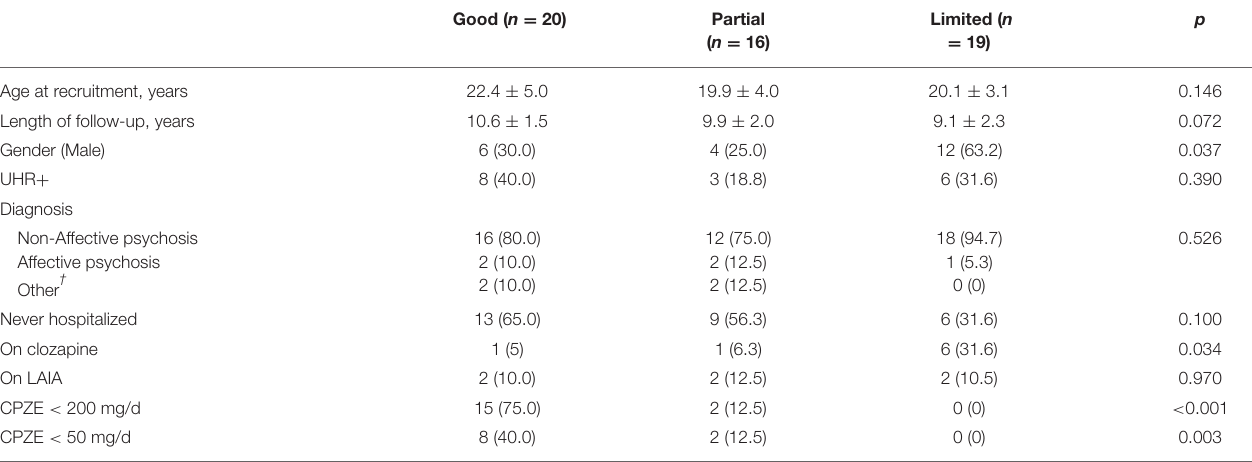
TABLE 3 | Factors related to functioning during long-term